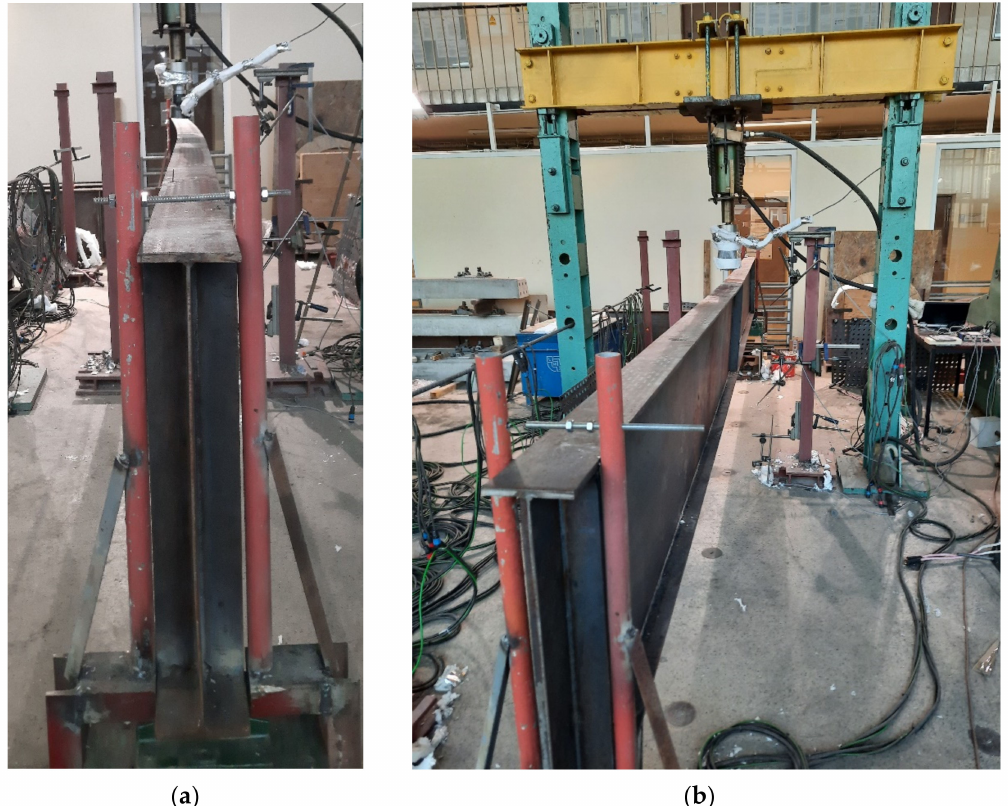
Figure 17. Steel plate girders after the test: ( a ) B1; ( b ) B2.